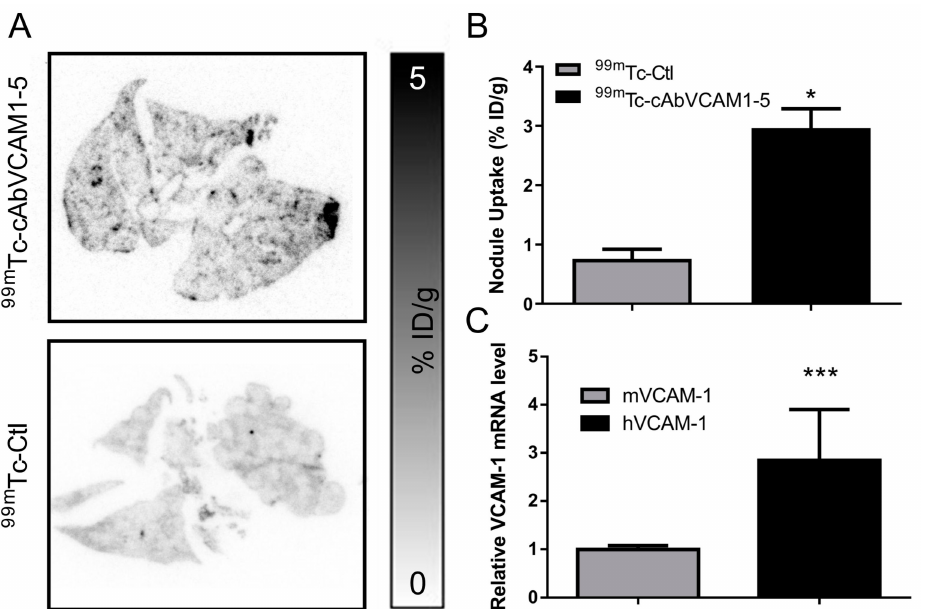
Figure 6. Ex vivo assessment of 99m Tc-cAbVCAM1-5 uptake in metastatic nodules and assessment of VCAM-1 expression by RT-qPCR. ( A ) Autoradiography on 20 µ m metastasis-containing lung slices. ( B ) Autoradiographic image quantification of 99m Tc-cAbVCAM1-5 and 99m Tc-Ctl uptake in MDA-MB-231 metastatic nodules. * p < 0.05 vs. 99m Tc-Ctl. ( C ) 50 mg of lung containing metastases (MDA-MB-231) were harvested and tested for human and mice VCAM-1 expression by RT-qPCR. *** p < 0.001 vs. MDA-MB-231